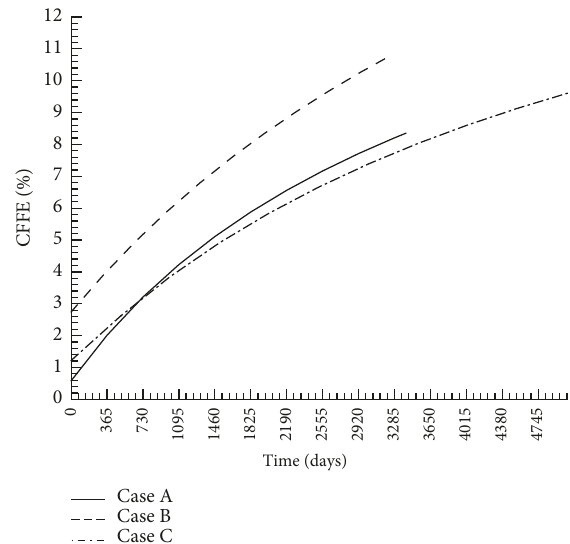
Figure 3: Increase in cumulative fissile fuel enrichment during the operation times.